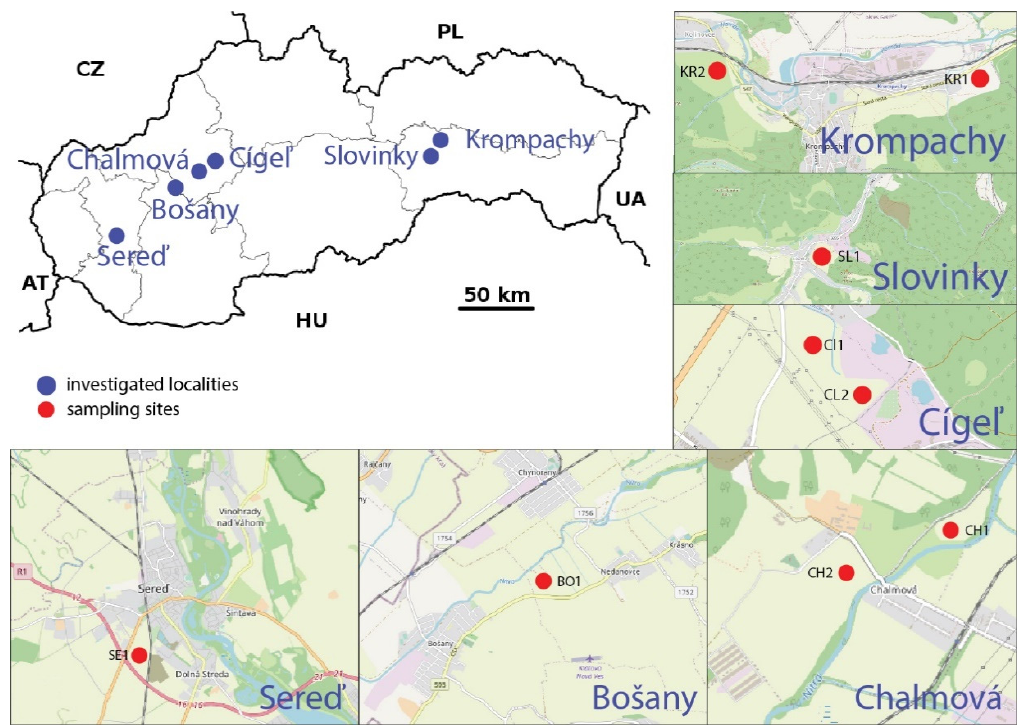
Figure 1. Location of research sites in the investigated areas (Slovakia).